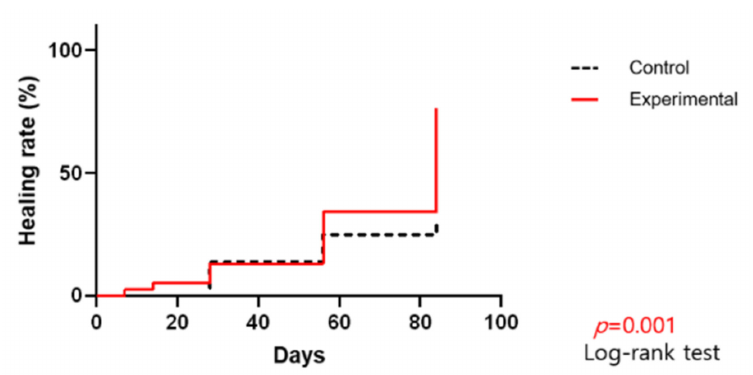
Figure 5. Percentage of wounds completely healed throughout the course of